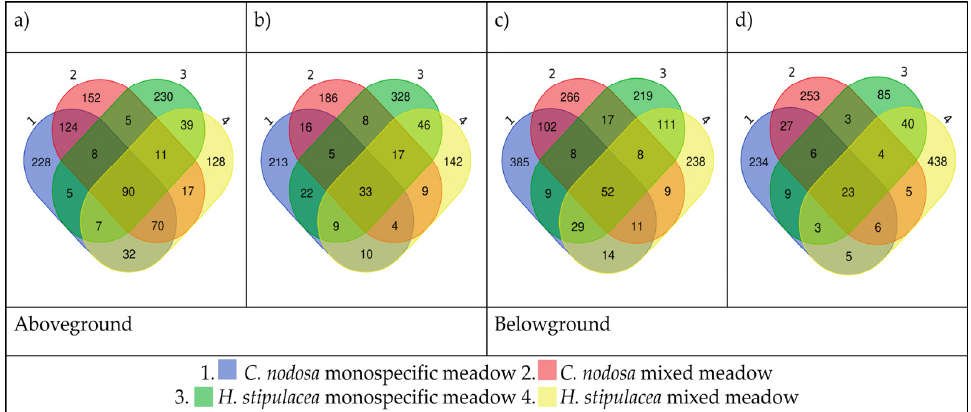
Figure 2. Venn diagram of the amplicon variant sequence (AVS) distribution on the aboveground seagrass tissues from the shallow site (#1; ( a )), and the deep site (#2; ( b )), or on the belowground seagrass tissues from site #1 ( c ) and site #2 ( d ).